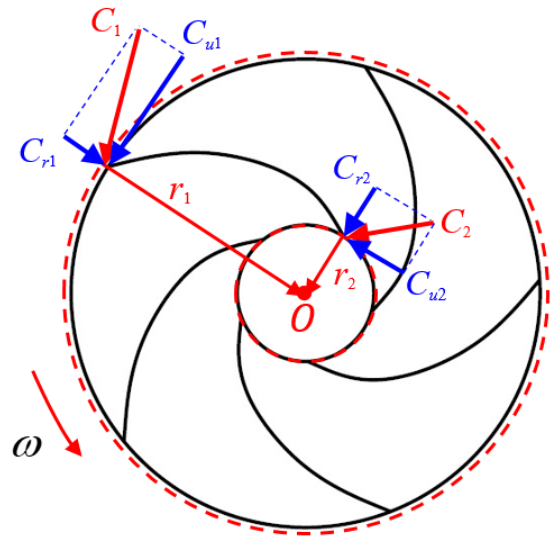
Figure 2. Change in the velocity and moment of momentum at the inlet and outlet of the runner control body.